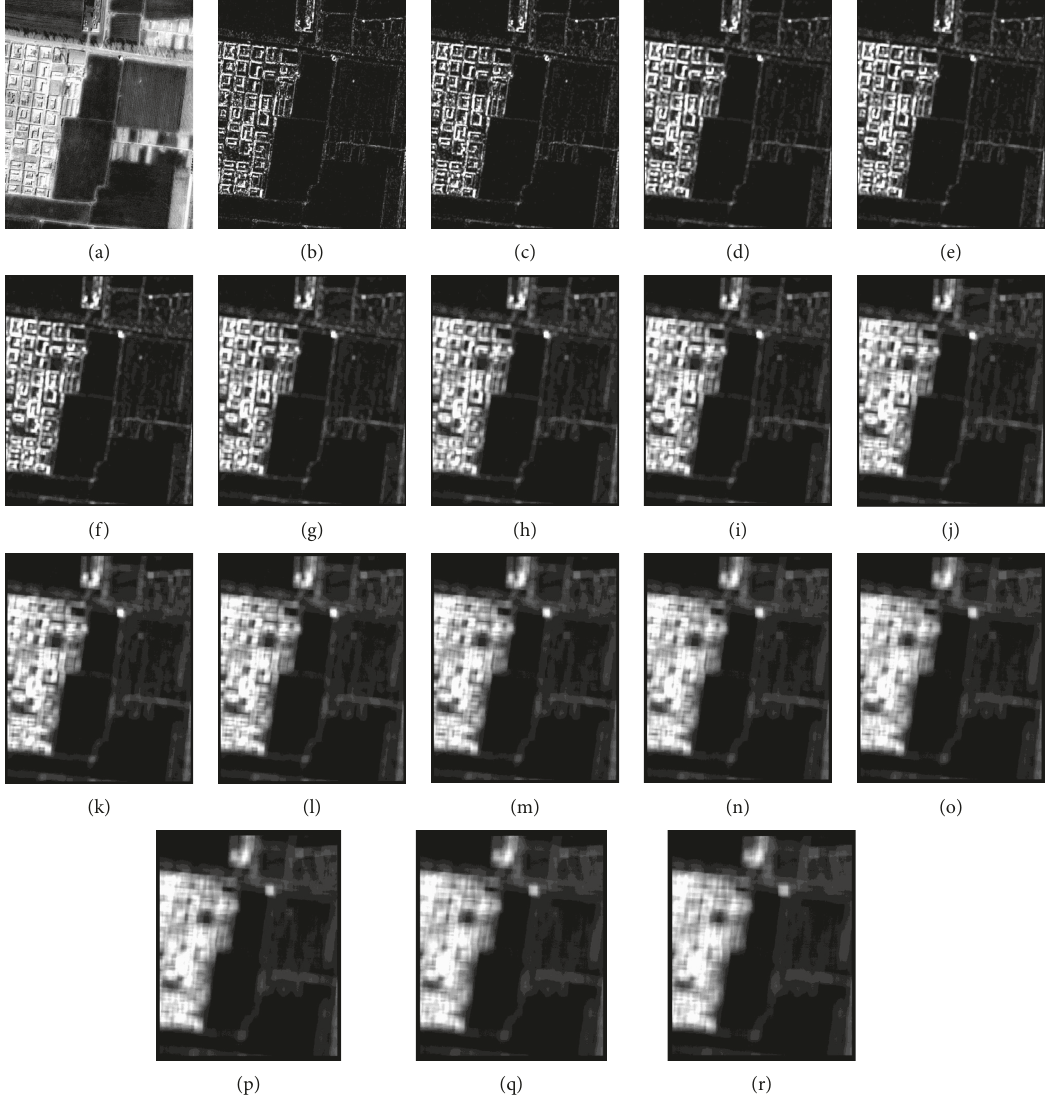
Figure 5: Contrast images at series scale: (a) original image, (b) 3 × 3, (c) 5 × 5, (d) 7 × 7, (e) 9 × 9, (f) 11 × 11, (g) 13 × 13, (h) 15 × 15, (i) 17 × 17, (j) 19 × 19, (k) 21 × 21, (l) 23 × 23, (m) 25 × 25, (n) 27 × 27, (o) 29 × 29, (p) 31 × 31, (q) 33 × 33, and (r) 35 ×